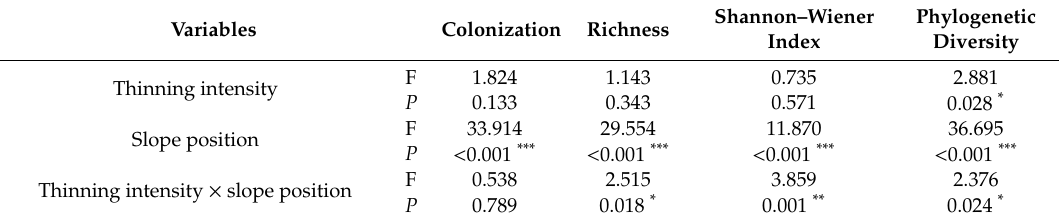
Table 2. Summary statistics of two-way ANOVA examining the e ff ects of thinning intensity and slope position as well as their interaction on arbuscular mycorrhizal fungi (AMF) colonization and